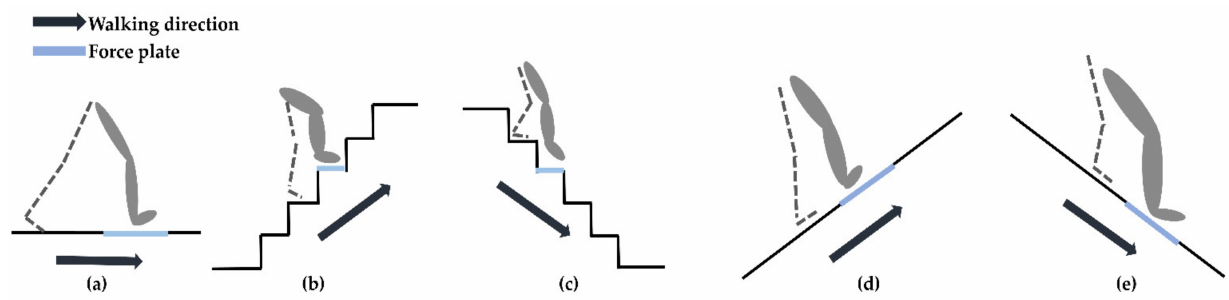
Figure 1. The five walking environments tested in this work ( a ) flat-ground, ( b ) upstairs, ( c ) downstairs, ( d ) uphill, and ( e ) downhill. A force plate was embedded in different positions according to each walking environment as shown by the blue line in each diagram. The force plate was embedded in the floor of the flat- ground environment as shown in ( a ). The experimental staircase was designed with five steps, here the force plate was embedded in the third step as shown in ( b , c ). The sloped walkway was made of three pieces joined together, the force plate was embedded in the second piece as shown in ( d , e ).